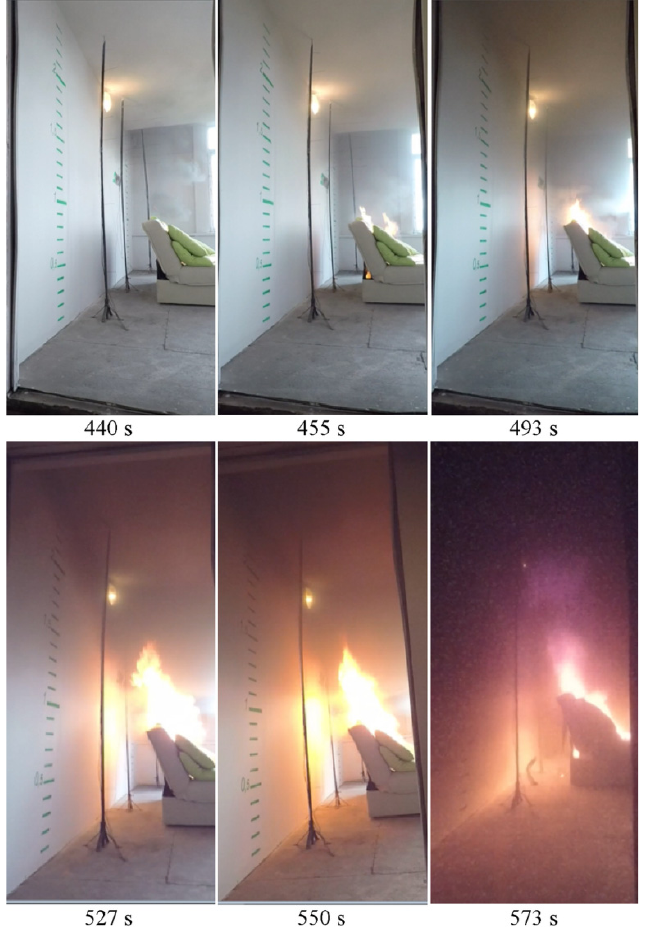
Figure 4. Subsequent stages of fire development (the first test). Time in seconds from the moment of